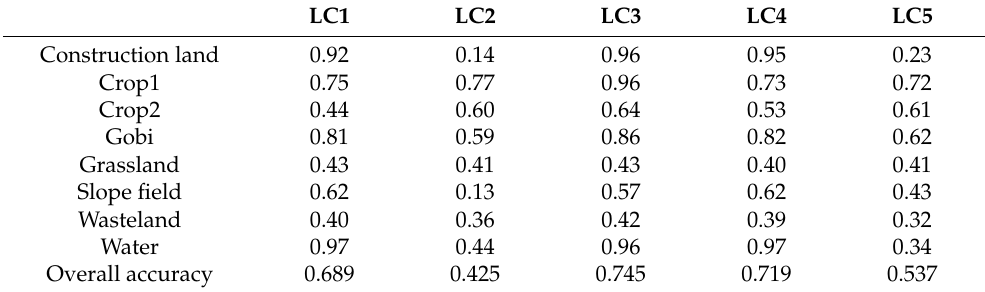
Table 4. Comparison of the class-wise classification accuracy for each method in the AHB